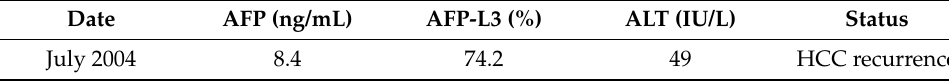
Table 3. Case 3. AFP, L3%, and ALT at time of HCC recurrence.